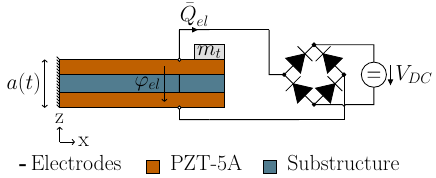
Fig. 1 Bimorph electromechanical structure coupled to a standard circuit